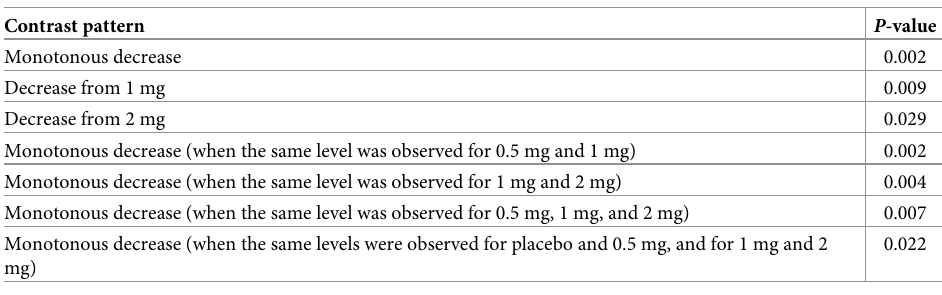
Table 2. Dose-response profile (contrast